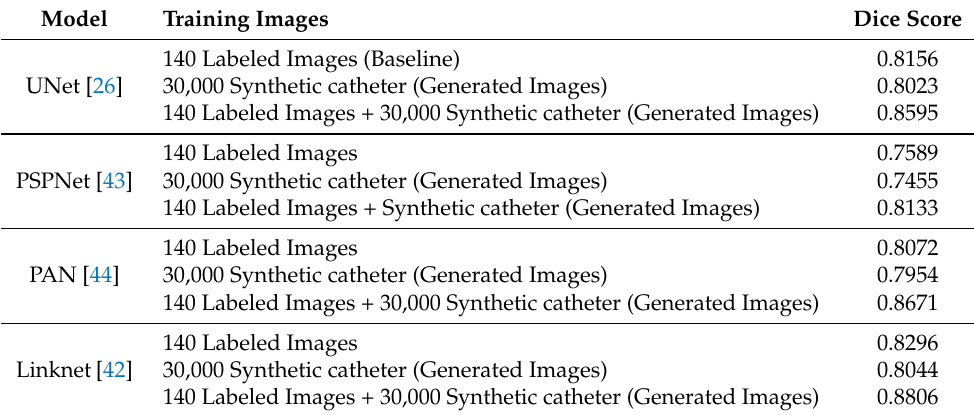
Table 1. Comparison of segmentation models with labeled and generated images. All of the segmentation models are evaluated on real catheter X-Ray test set.